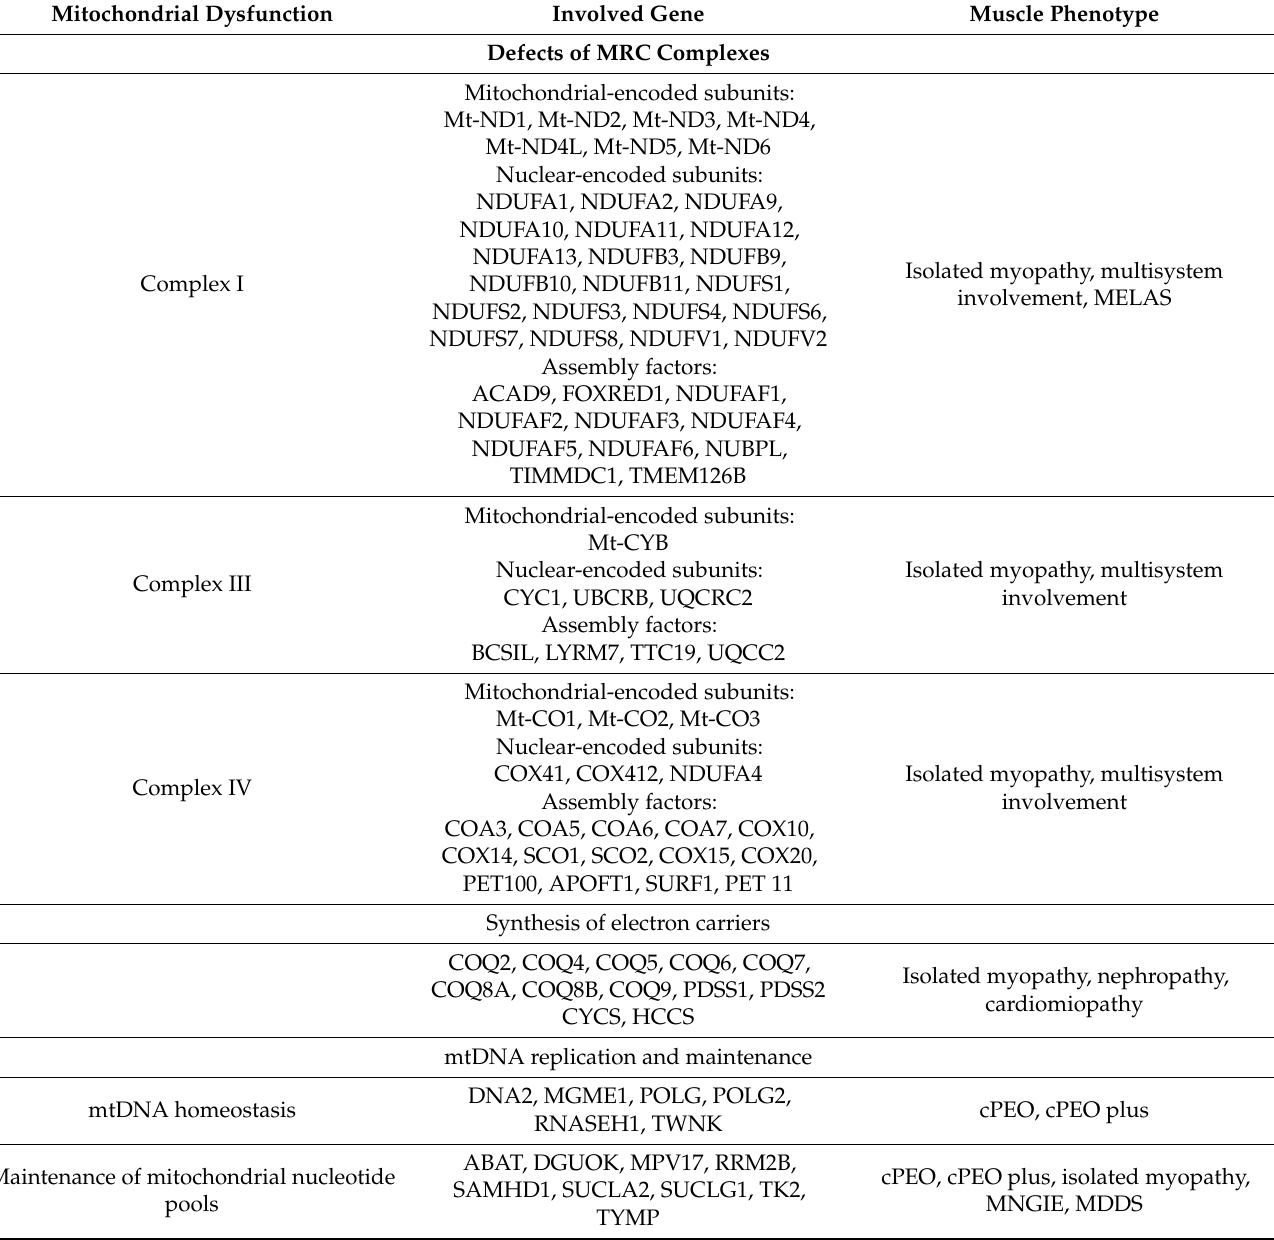
Table 1. Type of mitochondrial dysfunction and main PMM